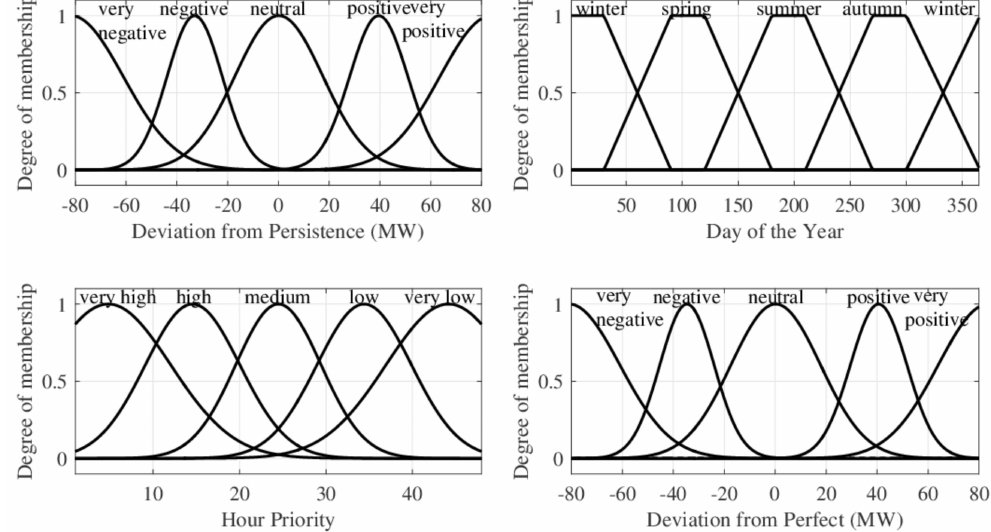
Figure 4. Classes’ definition for the concentrated solar power (CSP) plant example case. The classes of deviation from persistence , hour priority and deviation from perfect are determined by unsupervised learning, while the ones of day of the year are predetermined, based on the meteorological